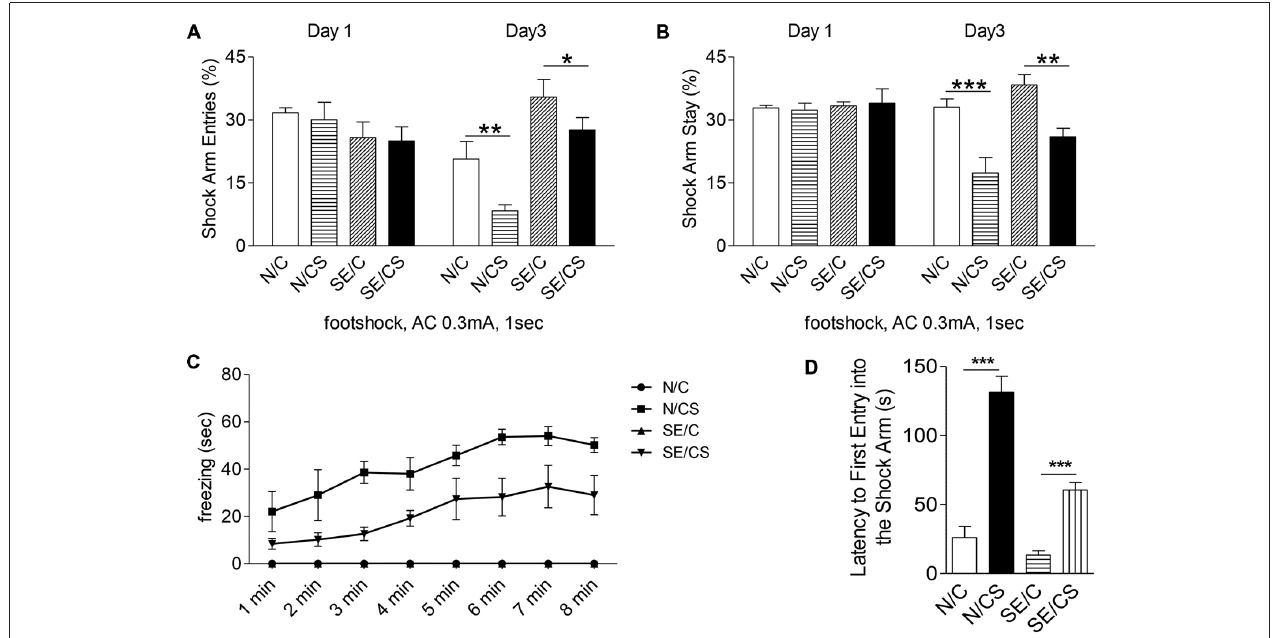
FIGURE 3 | Pilocarpine-induced epilepsy in mice impairs fear memory. Graphs showing the percentage of shock arm entries (A) and shock arm stay (B) of the four groups of mice (N/C—control mice, no foot shocks; N/CS—control mice, with foot shocks; SE/C—SE mice, no foot shocks; SE/CS—SE mice, with foot shocks) on habituation day (day 1) and on test day (day 3). Graph showing the freezing time (sec) in control or SE mice with (N/CS and SE/CS groups) or without (N/C and SE/C groups) foot shocks on day 2, when a series of four foot shocks was given (C) . Graph shows the latency of first entry into the shock arm of the four groups of mice as indicated (D) (ANOVA post hoc test, ∗∗∗ p < 0.001, ∗∗ p > 0.01, ∗ p <